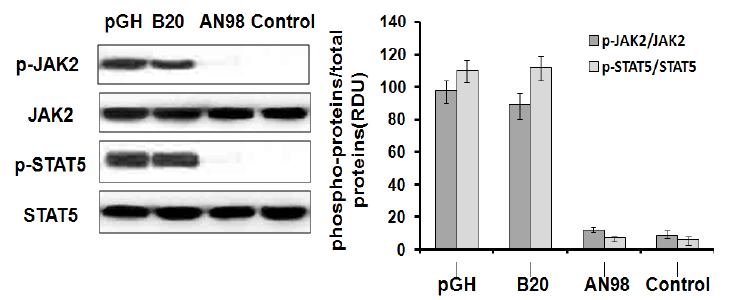
Figure 3. AN98 did not activate JAK2-STAT5. The CHO-PRLR cells were pre-treated as described in the materials and methods. The cells were treated with pGH, B32, AN98 or the control antibody (20 nM) for 30 min. Western blots were then performed with the indicated antibodies. The figures represent at least three independent experiments. JAK2-STAT5, janus kinase 2-signal transduction and activator of transcription.